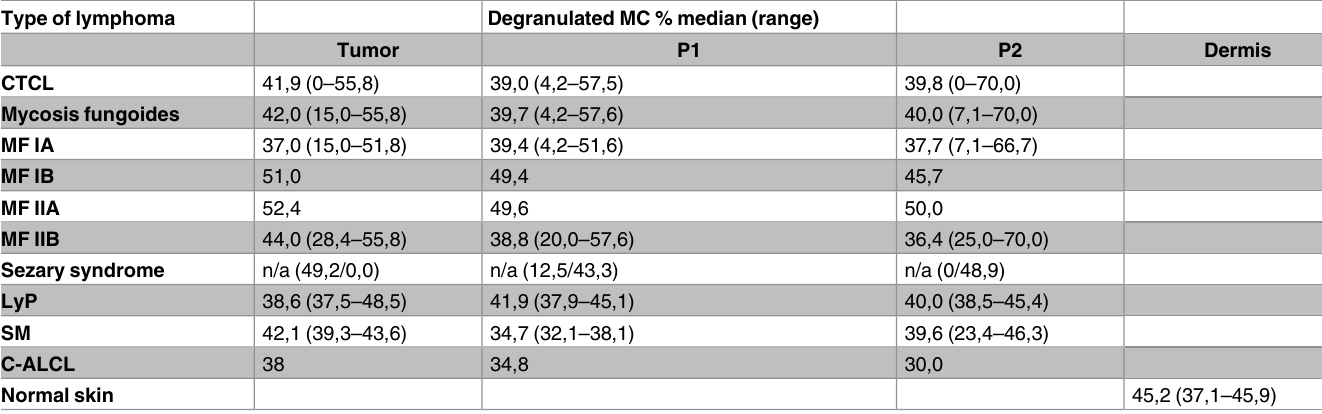
Table 4. Percentage of degranulated MC in CTCL variants. Type of